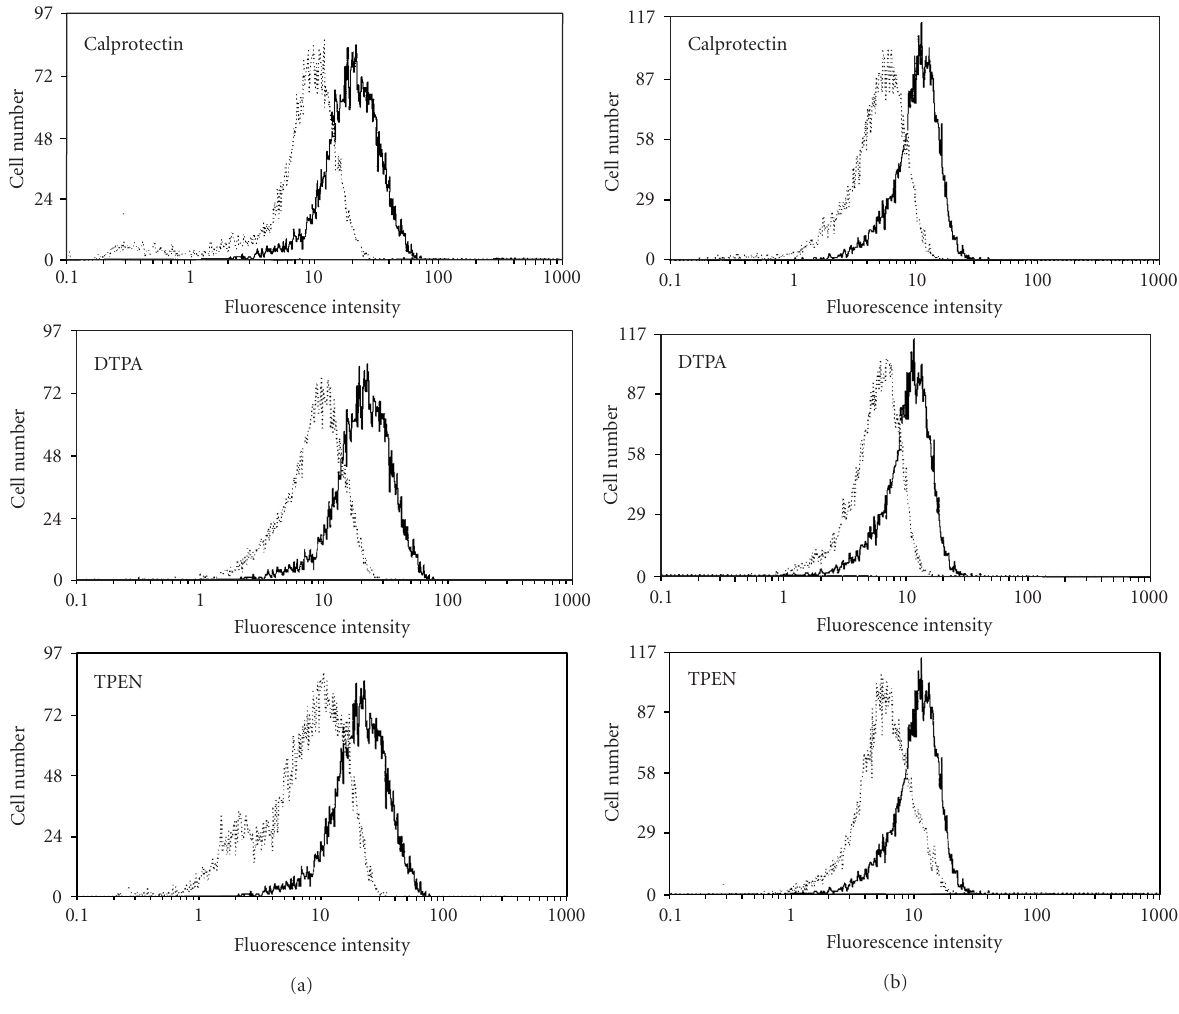
Figure 2. Reduction of the intracellular zinc concentration of (a) MM46 cells and (b) EL-4 cells treated with S100A8/A9 complex, DTPA, or TPEN. The cells were cultured without (solid line) or with (dotted line) 5 µ M S100A8/A9, 5 µ M DTPA, or 5 µ M TPEN for 6 hours, respectively. The intercellular zinc concentration was measured using Zn-specific fluorescence probe, FluoZin3,AM as described in “materials and